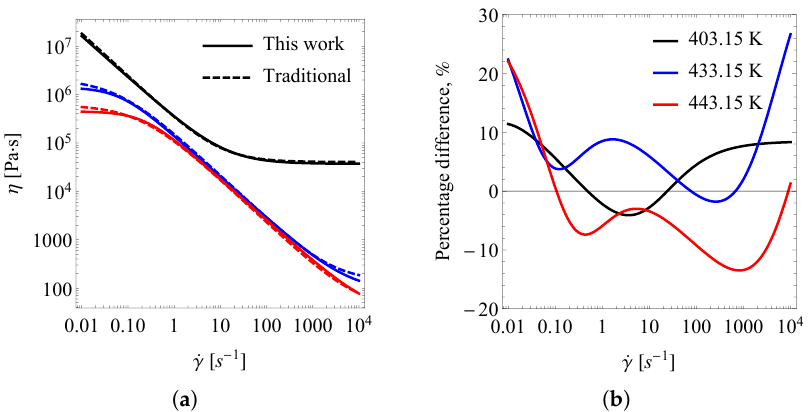
Figure 7. ( a ) Viscosity vs. shear rate at three different temperatures: traditional method (- - - -) and Scenario 1 (—–); and ( b ) percentage difference between the two model